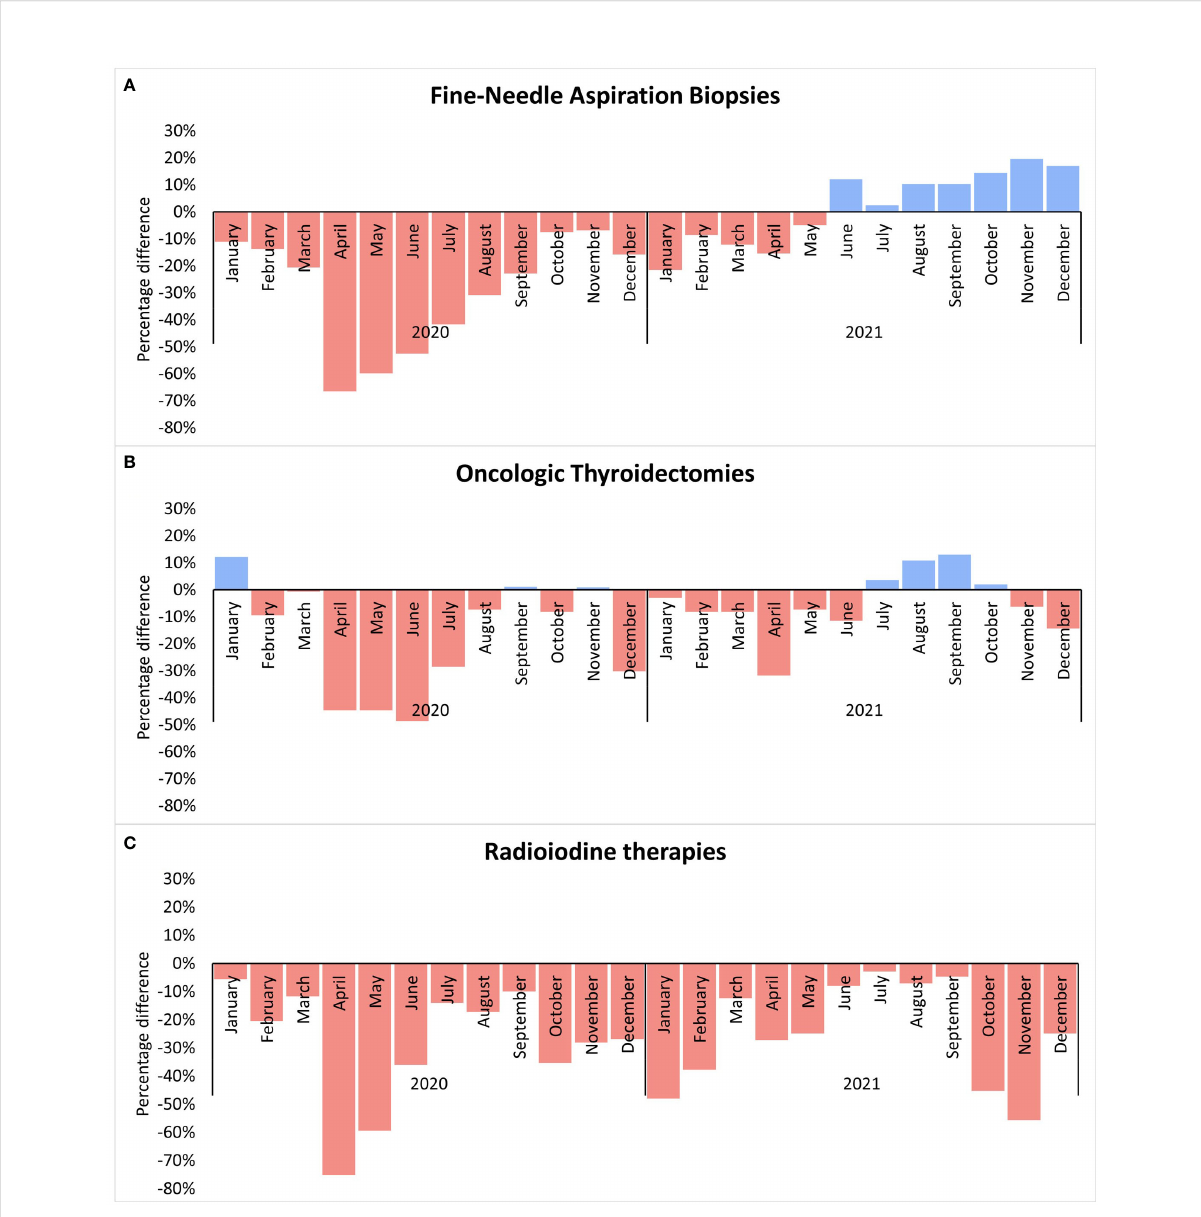
FIGURE 2 The percentage difference for each month of 2020 and 2021 in comparison with the 2019 monthly average of each procedure. (A) Fine-Needle Aspiration Biopsies; (B) Oncologic Thyroidetomies; (C) Radioiodine